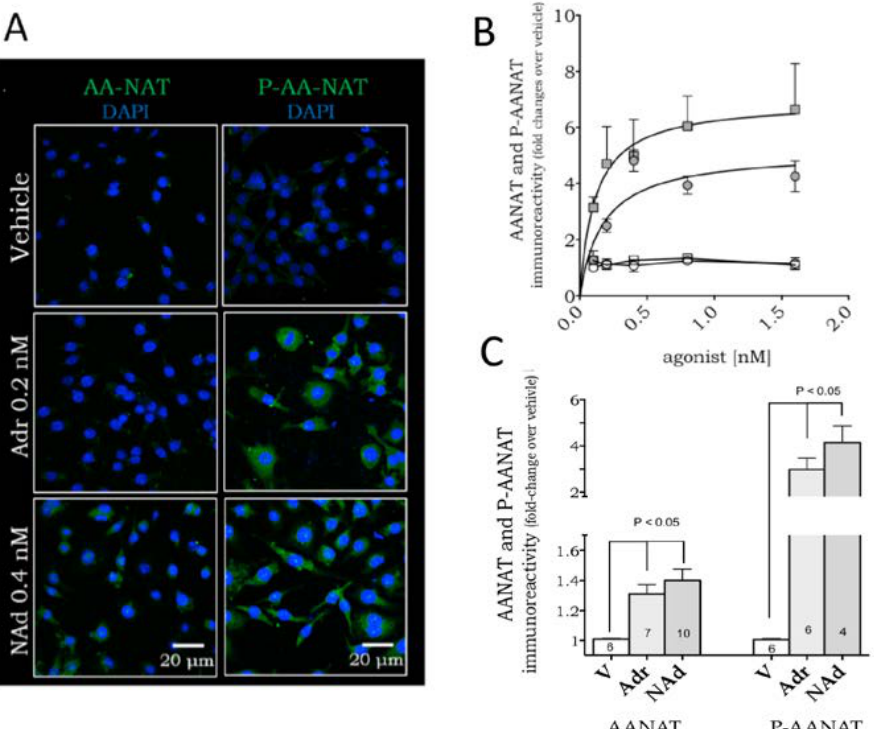
Figure 2. Adrenaline and noradrenaline induce expression of AANAT and P-AANAT in RAW 264.7 macrophages. ( A ) Representative immunofluorescence showing AANAT or P-AANAT expression in the cytoplasm of cells stimulated with adrenaline (Adr, 0.2 nM) or noradrenaline (NAd, 0.4 nM). The enzyme expression is shown in green, and the nuclei are stained by DAPI (blue); ( B ) Dose-response curve of AANAT (white symbols) and P-AANAT (grey symbols) expression in RAW 264.7 cells incubated with increasing concentrations of adrenaline (circles) or noradrenaline (squares); ( C ) The same data presented in ( B ), of AANAT and P-AANAT expression induced by adrenaline (0.2 nM) and noradrenaline (0.4 nM), compared to vehicle (V; 0.001% ethanol) and plotted as single concentrations to better compare the catecholamines effect on both enzymatic forms. Data are shown as mean ± SEM, normalized by the respective vehicle group. Data represent the mean of four to ten independent